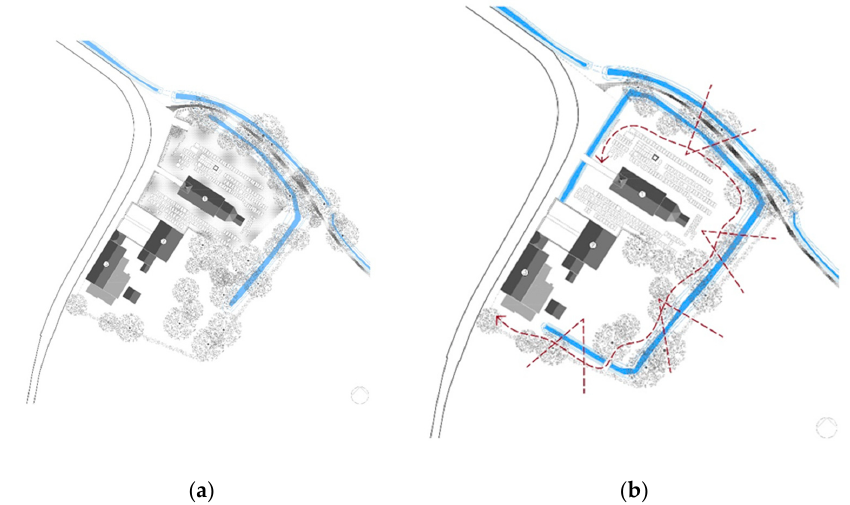
Figure 7. “Island” plan with 1. St. Odulphus church, 2. former rectory and 3. guild hall: ( a ) Existing situation with part of the historical moat surrounding the site; ( b ) Proposed situation with a reintroduction of the moat and the removal of lower vegetation to create an open view to the rural environment.